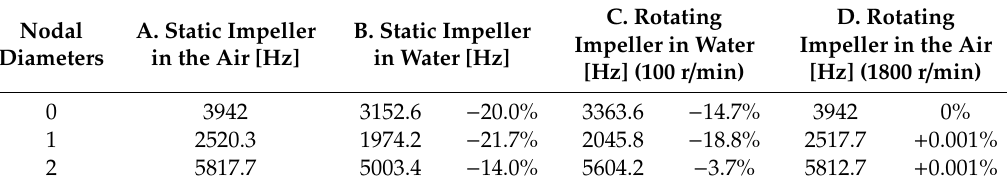
Table 1. Natural frequencies of the impeller by